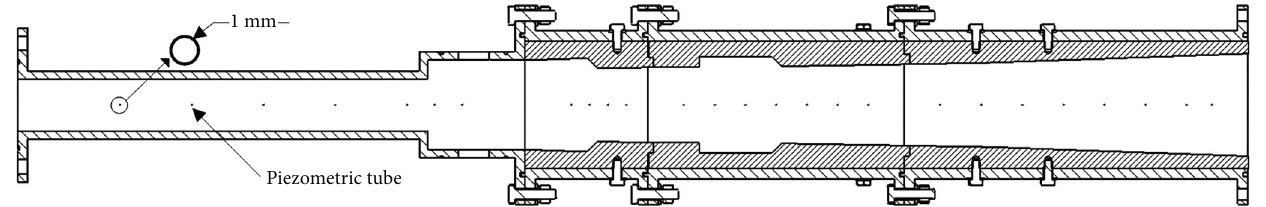
Figure 10: Schematic of the pressure measuring points.